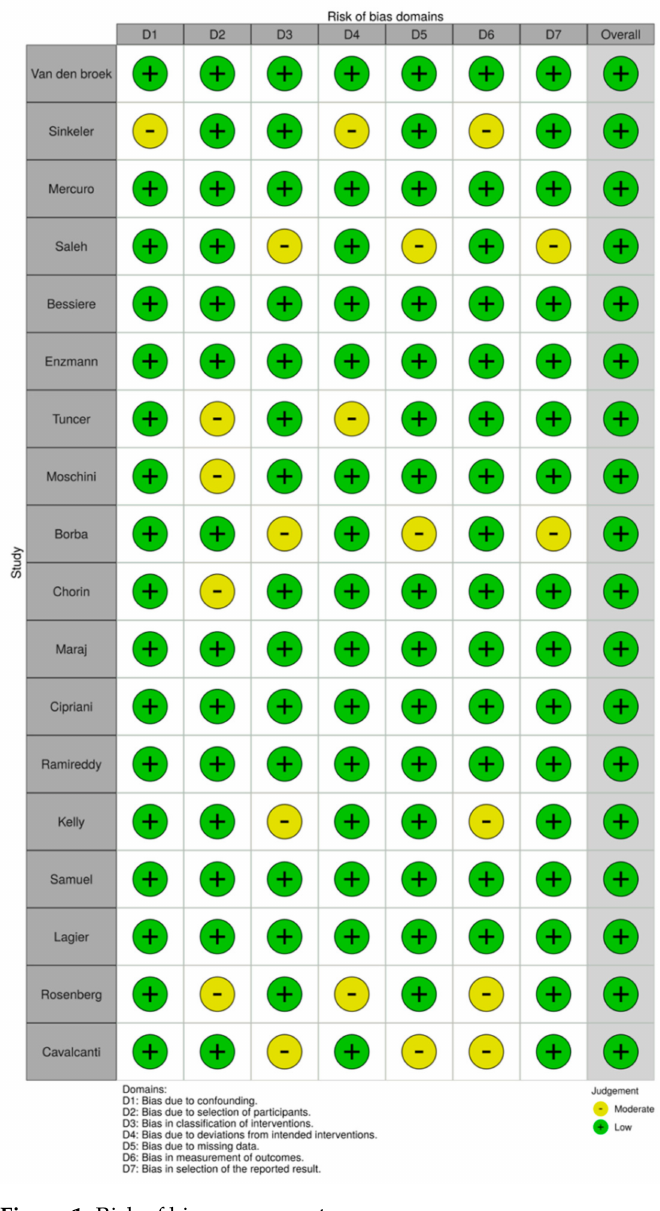
Figure 1. Risk of bias